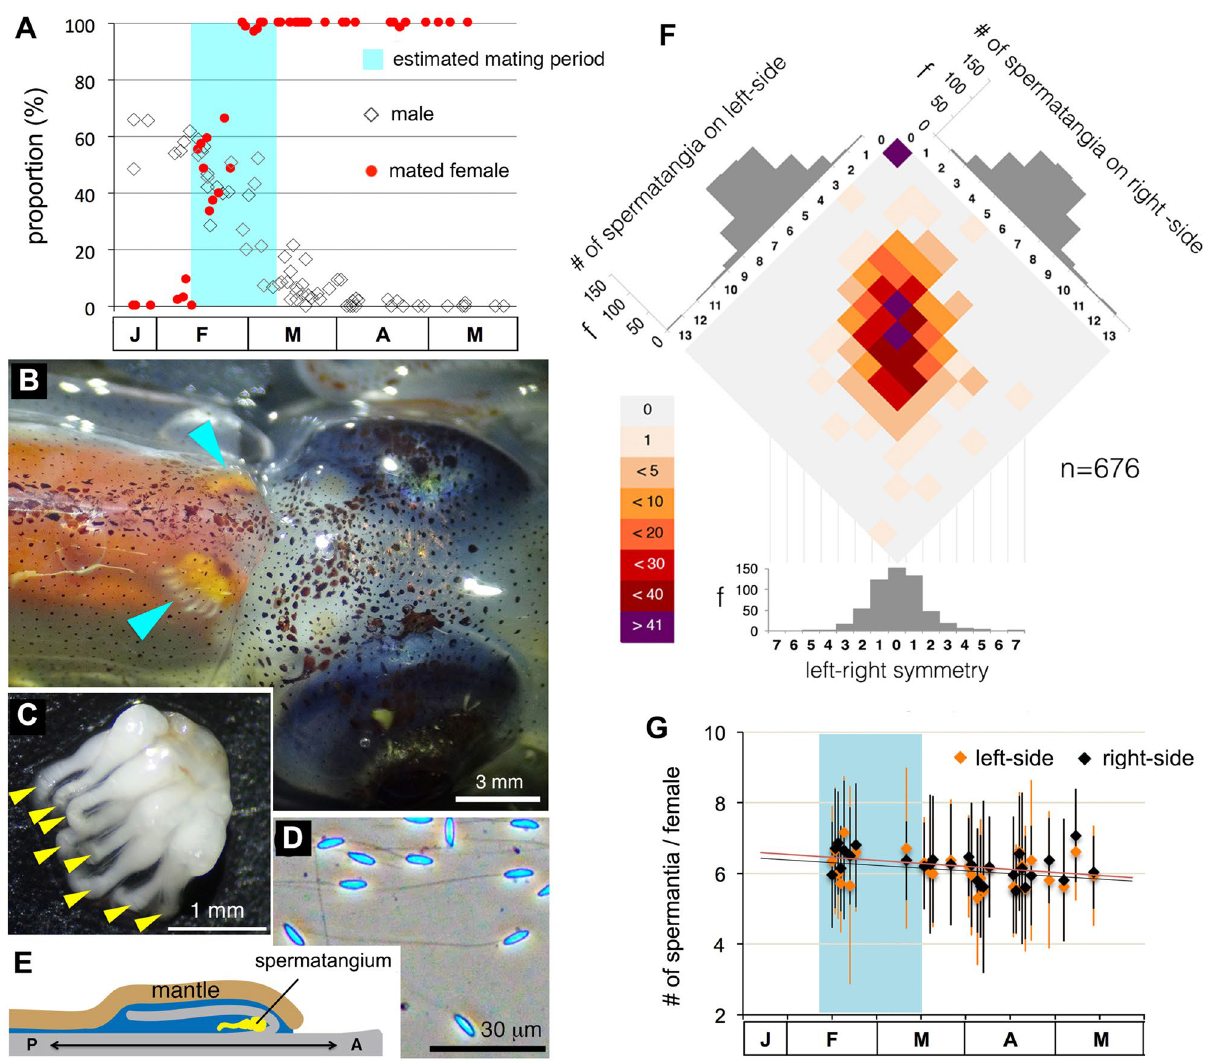
Figure 1. The mode of and change in sperm storage throughout the reproductive season in W. scintillans. ( A ) Population dynamics of males and mated females from January to May. A cyan box indicates the estimated mating period. Total of 1,414 males and 4,733 females were analyzed. ( B ) A dorsal view of the female around the neck. Arrowheads point to the spermatangia visible through the transparent mantle. ( C ) A single mass of spermatangium with unidirectionally oriented ejaculatory ducts (arrowheads). ( D ) Spermatozoa stored in the spermatangia. ( E ) An anatomical illustration of the female seminal receptacle along the body axis (A, anterior; P, posterior). ( F ) A heatmap represents the frequency of female individuals having different patterns of spermatangium number on bilateral sides of the seminal receptacle. Histograms show frequency distribution of spermatangium number for each side ( upper left and upper right ) and left–right symmetry ( bottom ). ( G ) No seasonal change in number of spermatangia stored in females. Total of 1,400 females were